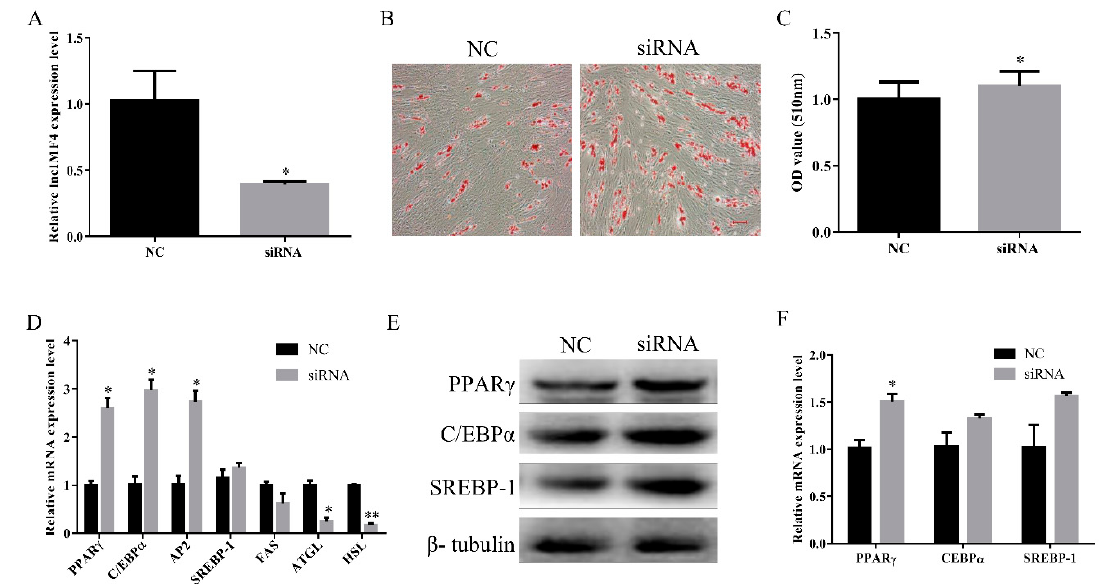
Figure 4. Knockdown of lncIMF4 promoted adipocytes lipogenesis. LncIMF4 siRNA or NC were transfected into cells at 70% density at 50 nM. ( A ) The inhibition efficiency of lncIMF4 in porcine intramuscular adipocytes after transfecting lncIMF4 siRNA with NC on 6 day of differentiation. ( B ) Oil Red O staining, scale bar = 100 μ m. ( C ) Absorbance value at 510 nm after incubation with Oil Red O. ( D ) RT-qPCR analysis of adipogenic and lipolytic genes on 6 day of differentiation. ( E ) Western blot analysis of adipogenic genes on 6 day of differentiation. ( F ) The quantification of protein levels. The results were representative of means ± SEM of three independent experiments. *, p < 0.05; **, p < 0.01.